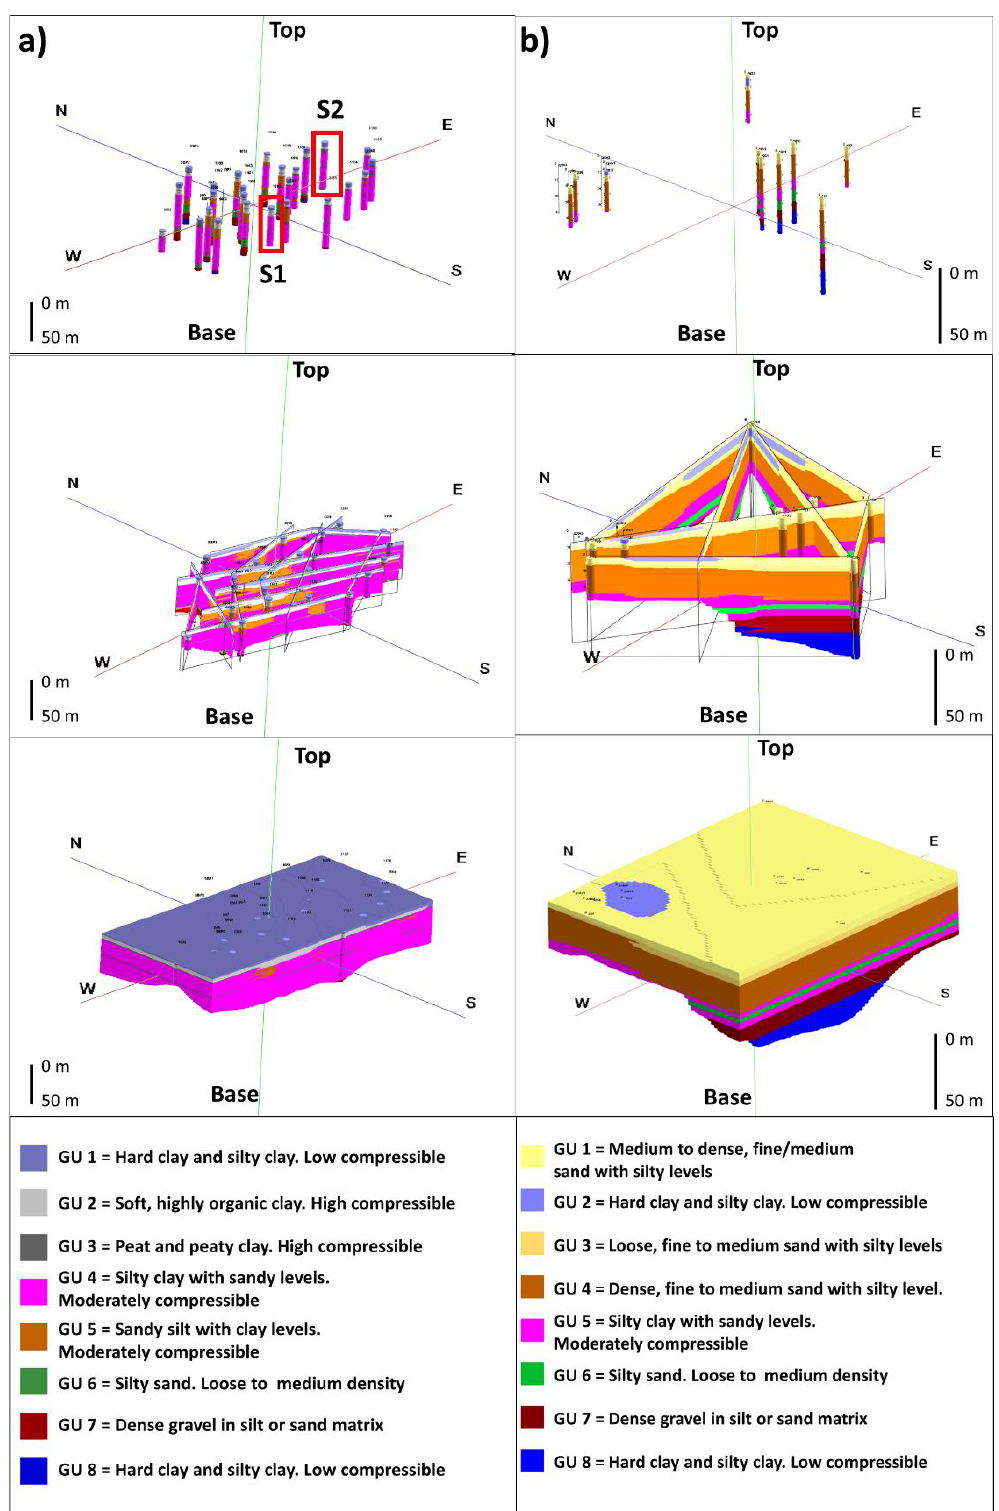
Figure 7 . Geotechnical 3D models of ( a ) sector 1 (Rome Fair region and Commercity, inner delta) and ( b ) sector 2 (offices of the Leonardo Da Vinci airport, outer delta). The figure also shows the processing chain for the 3D geotechnical model, which started from the collection and interpretation of borehole data (first images on the top), followed by their correlation as fence diagrams, and finally interpolated as continuous surfaces (last images at the bottom).